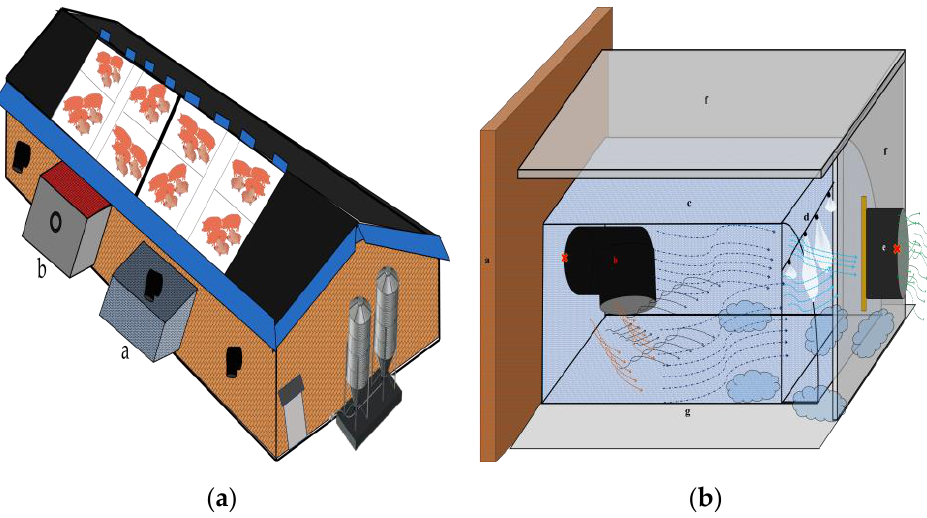
Figure 1. Schematic diagram of the experimental setup, ( a ) swine facility: a . curtain set up, b . metallic cover setup, ( b ) curtain and metallic cover setup: a. barn wall, b. exhaust fan, c. curtain, d. spraying nozzles, e. single hole, f. metallic cover, g. floor, “x” markings represent the NH 3 sampling point.